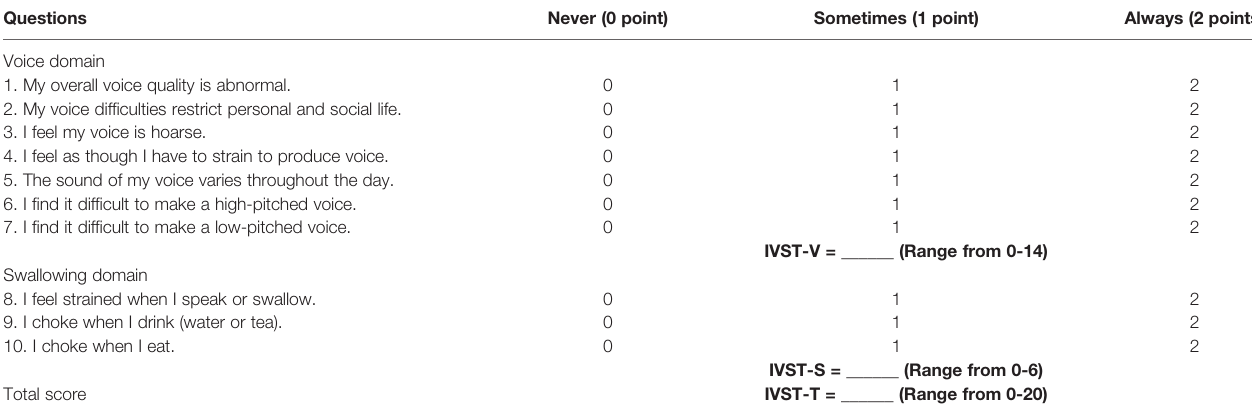
TABLE 1 | Index of voice and swallowing handicap of thyroidectomy